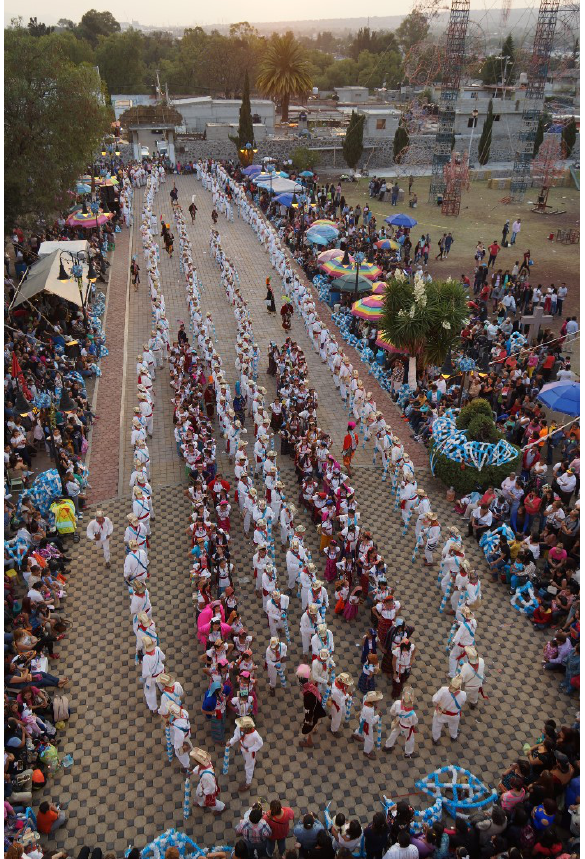
Figure 5 Serranos dancers during the celebration of the feast of Our Lord of Graces, 2019. Tepexpan, Acolman, State of Mexico. Copyright: Jorge Antonio